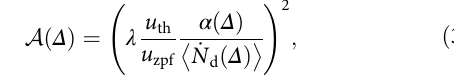
temperature, taken as 4 K assuming thermalization of the oscillator to the He bath (see section II 3 and Methods). For